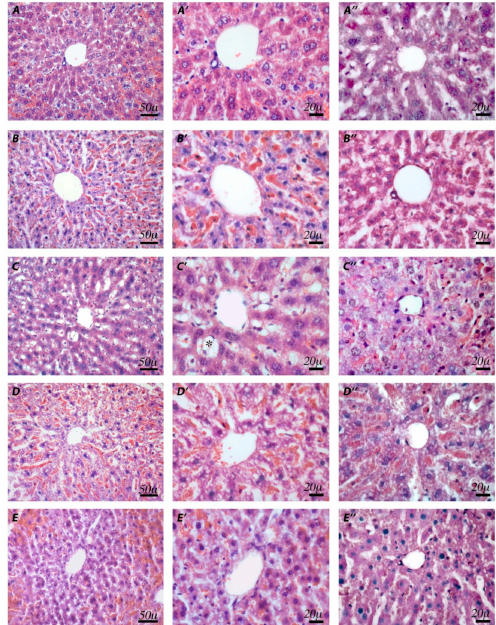
Figure 8. Histological observations of different treatments in mouse livers. Hematoxylin–eosin ( A – E (cid:48) ) and PAS staining ( A (cid:48)(cid:48) – E (cid:48)(cid:48) ). Untreated ( A , A (cid:48) ) and vehicle ( B , B (cid:48) ) samples show normal organization of hepatocytes and sinusoids. Indomethacin ( C , C (cid:48) ) samples demonstrate dilatations of the sinusoids and hydropic hepatocytes with displacement of nuclei (*) of several hepatocytes. In ketorolac ( D , D (cid:48) ) samples, a foamy cytoplasm appearance is evident in the hepatocytes. Ketogal ( E , E (cid:48) ) samples show a general improvement in hepatic tissue histology. PAS staining shows no substantial changes in the vehicle ( A (cid:48)(cid:48) ), compared to the untreated ( B (cid:48)(cid:48) ) samples. In indomethacin ( C (cid:48)(cid:48) ) and ketorolac ( D (cid:48)(cid:48) ) samples, a decrease in positivity is detectable. Ketogal ( E (cid:48)(cid:48) ) samples show a slight improvement in terms of